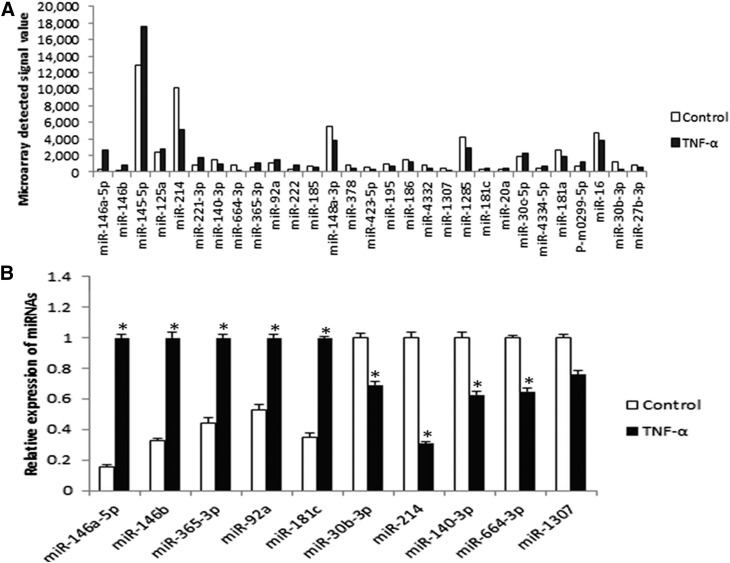
Differentially expressed miRNA profiles. A: Degree of up- and downregulation of the 29 significantly expressed miRNAs with strong signal values (signal ≥500). B: Real-time PCR analysis of randomly selected miRNAs from microarray assay. U6 was used as an internal reference (* P < 0.05, n = 6).